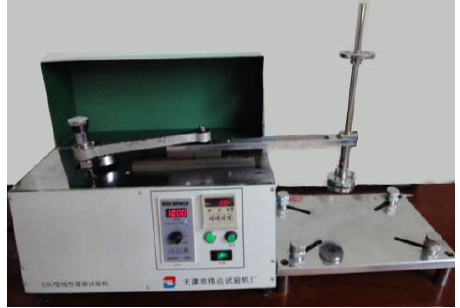
Figure 3. NUS-ISO-I linear reciprocating wear tester.